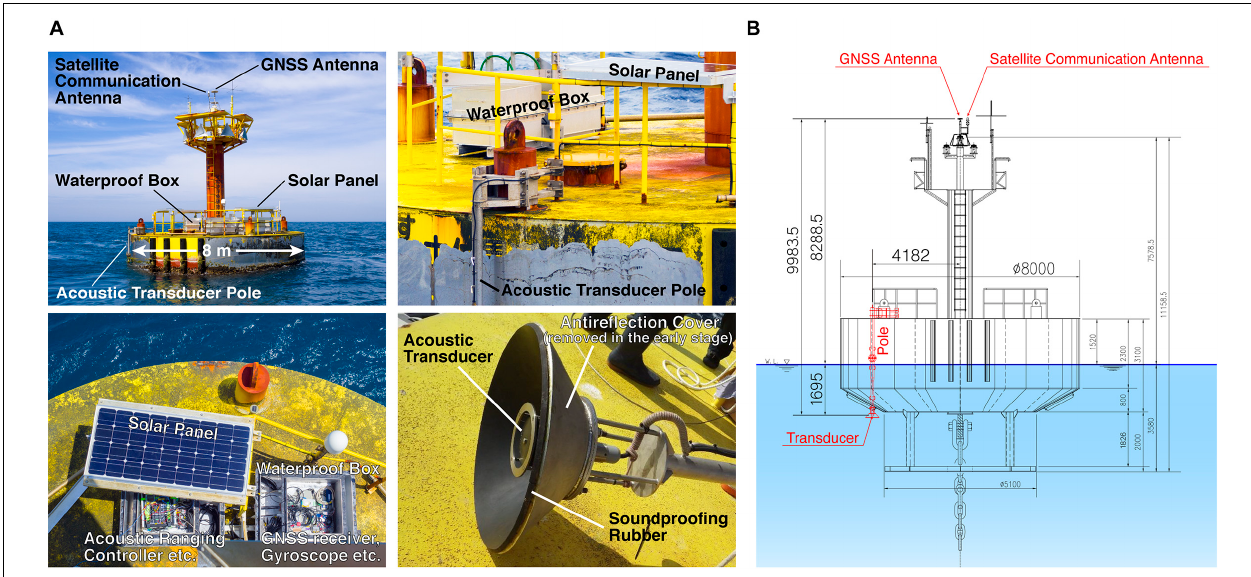
FIGURE 4 | Photo of an ocean bottom acoustic transponder installed in the test site. The black device fixed on the top is the acoustic transducer.